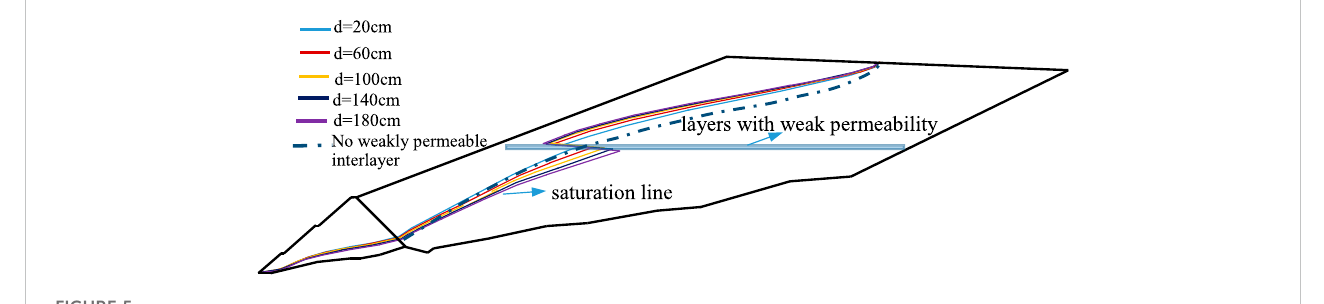
FIGURE 5 Diagram of in fi ltration line with the position of weakly permeable interlayer thickness.